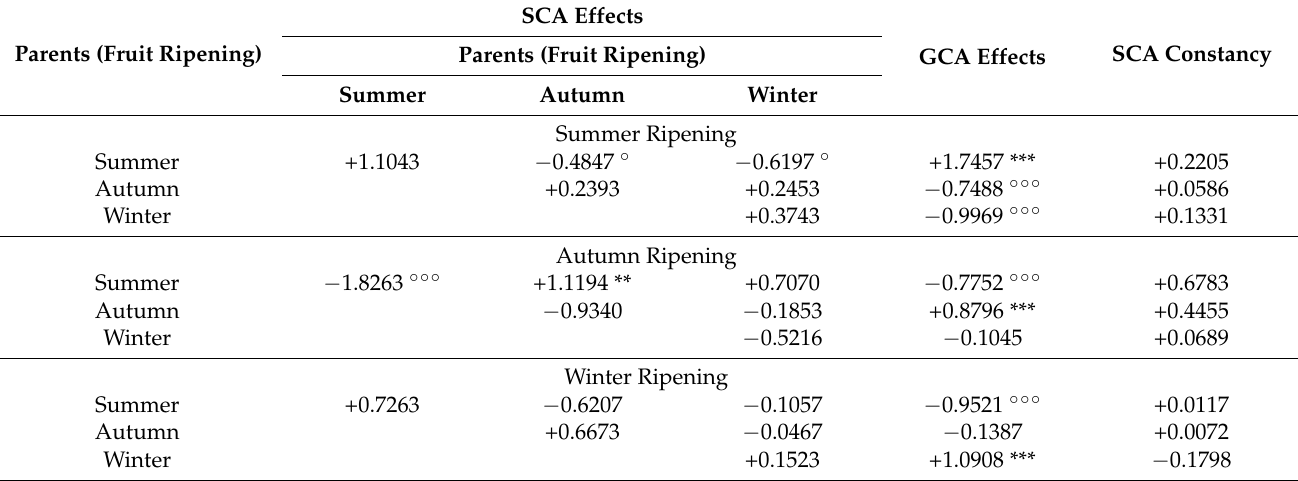
Table 7. The effects of general combining ability (GCA) and specific combining ability (SCA) on the ripening time of the fruit of F 1 apple hybrids depending on the ripening time of the